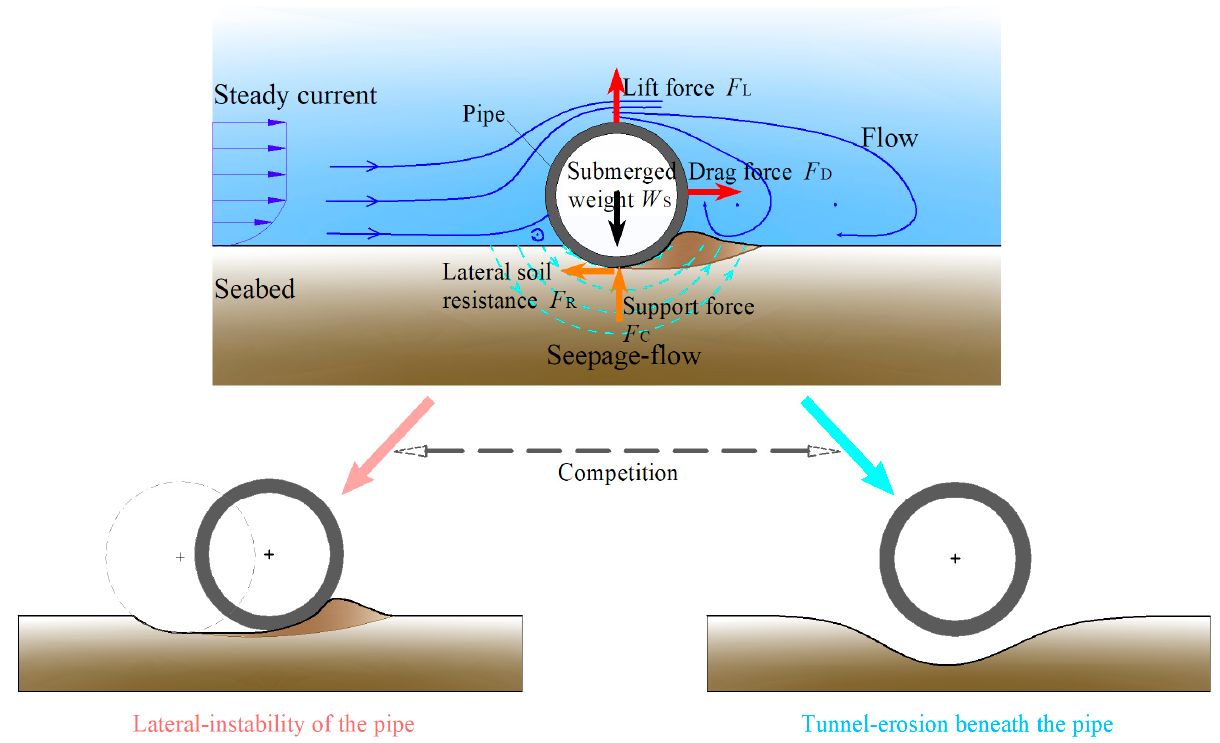
Figure 1. Illustration of flow–pipe–seabed interactions for a shallowly embedded pipeline: competition between lateral instability and tunnel erosion.